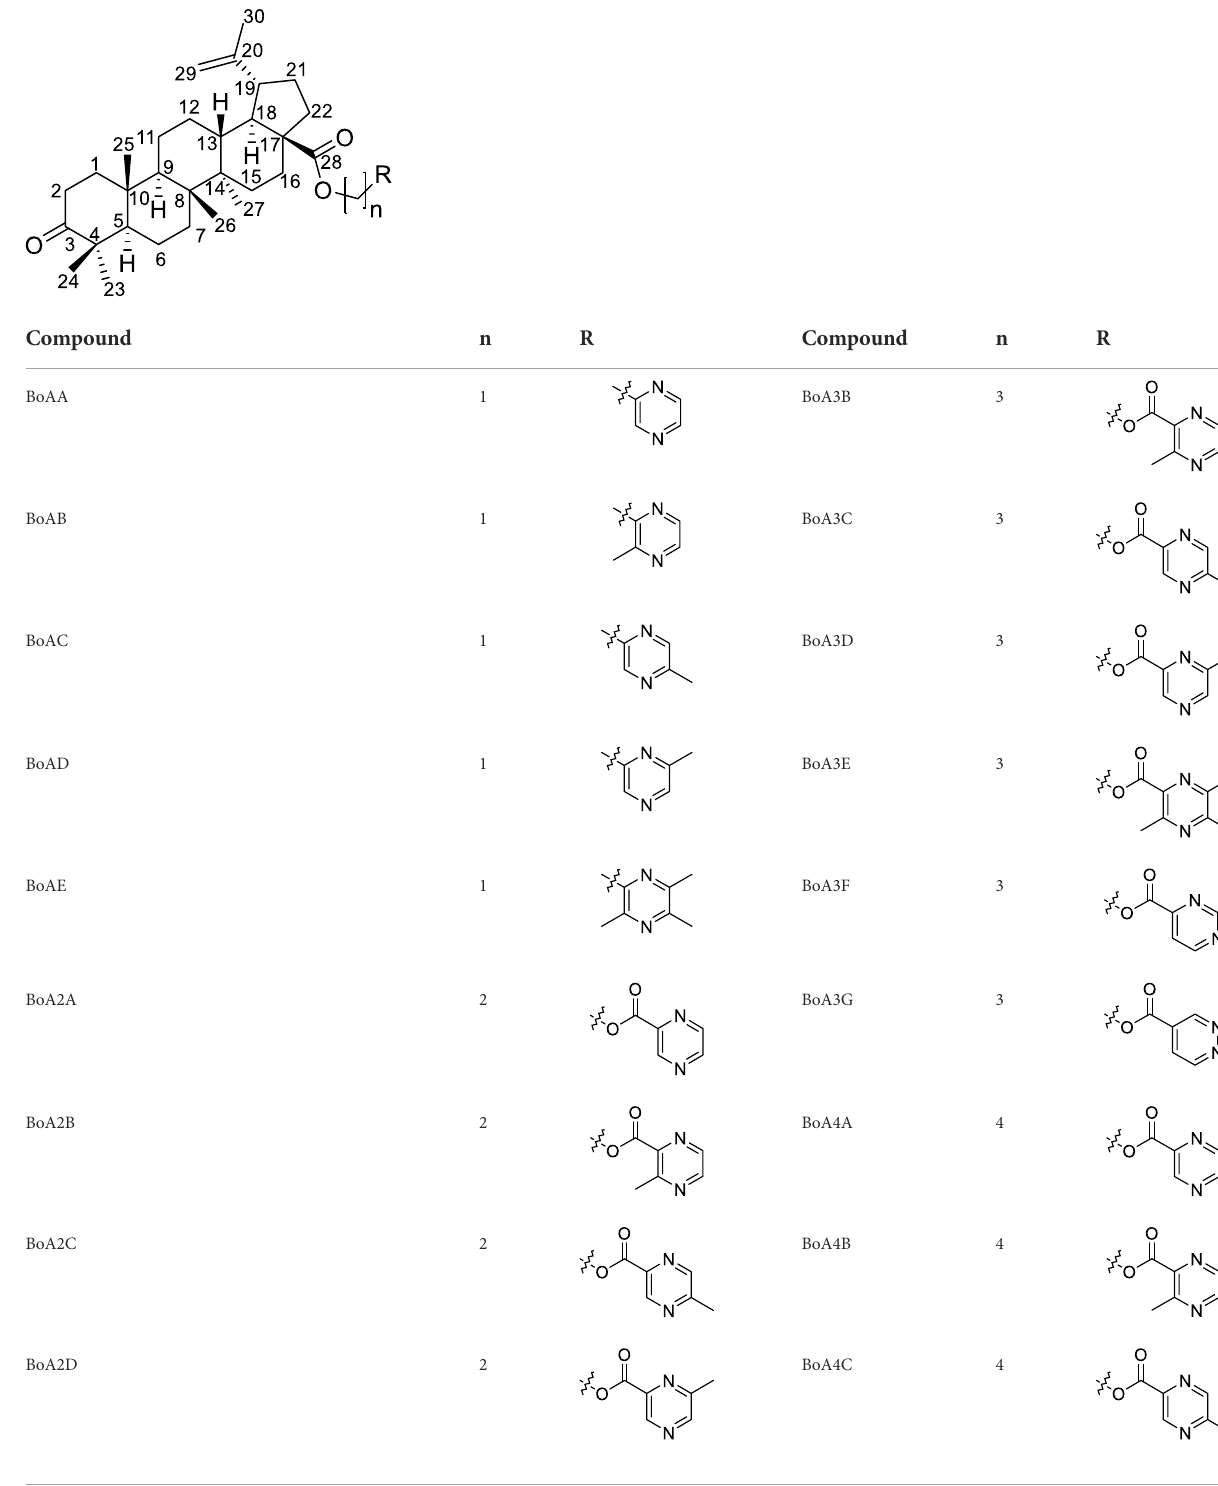
TABLE 1 Structures of the BoA